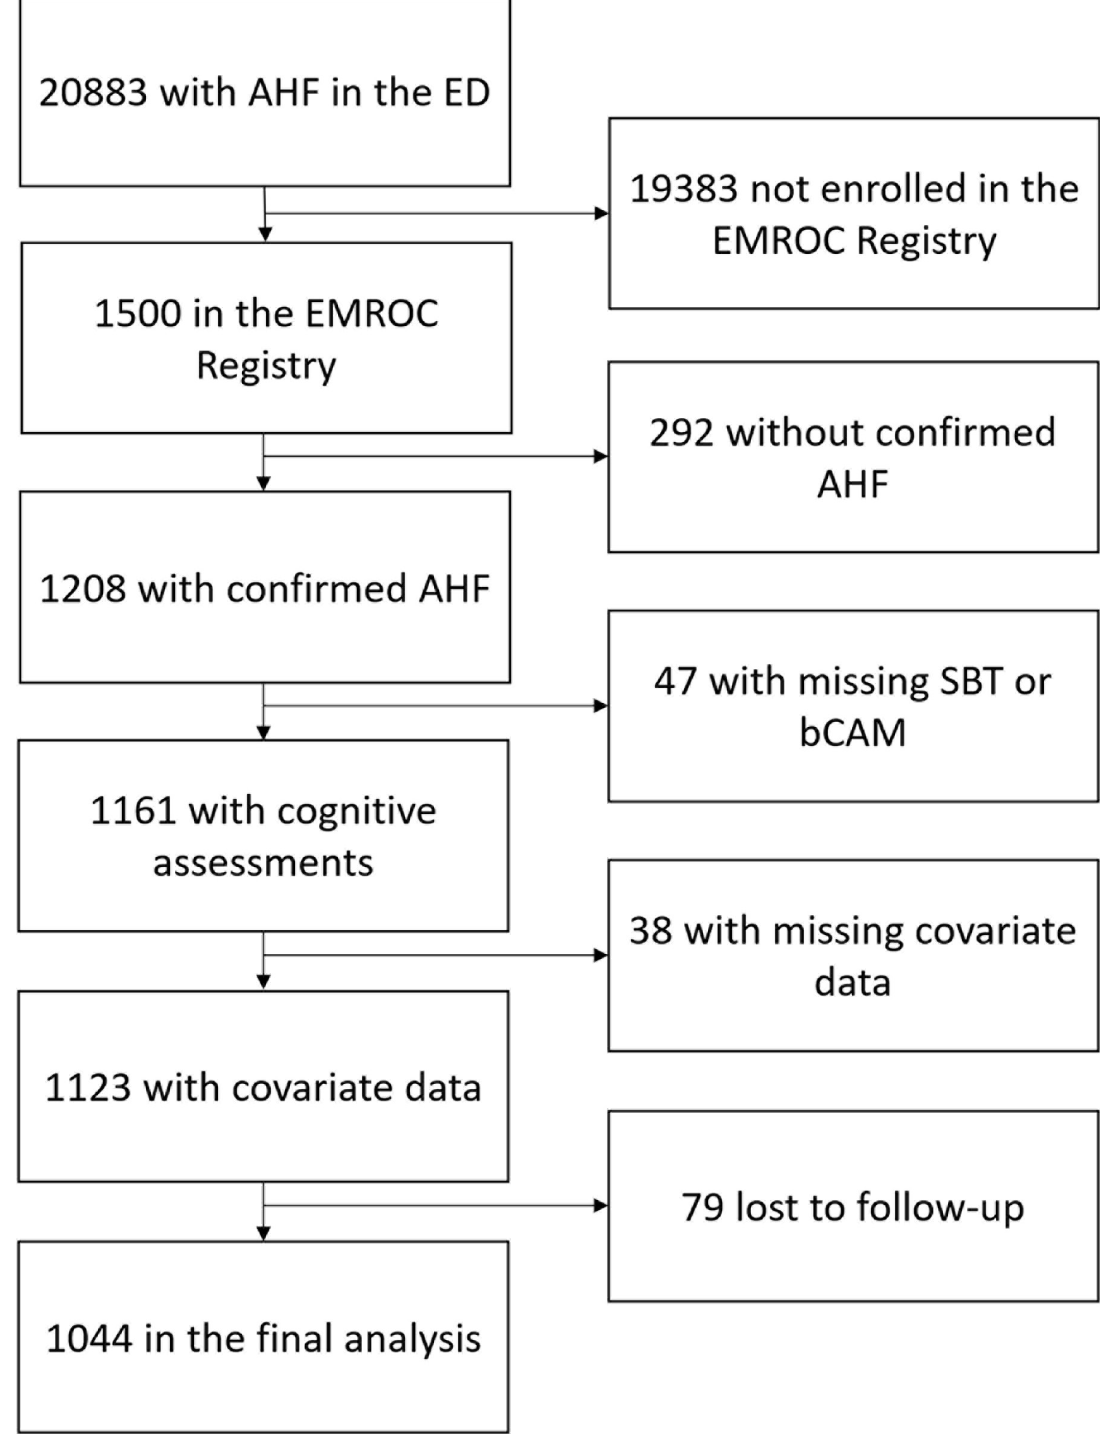
Fig 1. Enrollment flow diagram. AHF, acute heart failure; EMROC, Emergency Medicine Research Outcomes Consortium. SBT, Short Blessed Test; bCAM; Brief Confusion Assessment Method.